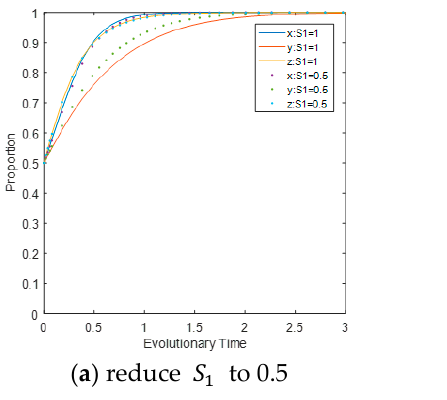
Figure 3. Impact of 𝑆 (cid:2869) on the evolutionary path of multi-agents.